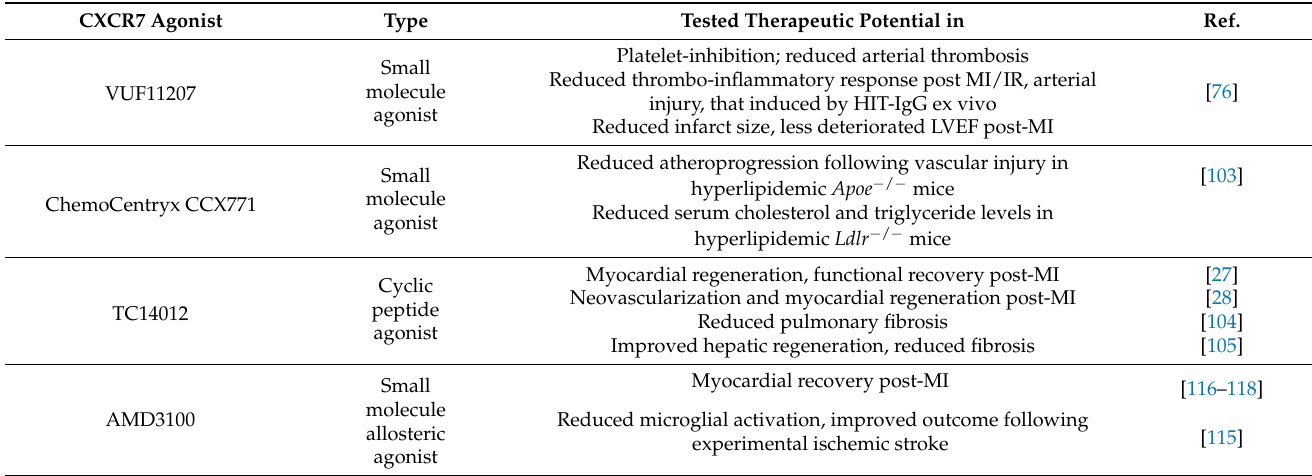
Table 2. Currently available CXCR7-agonists for pre-clinical validation in cardiovascular